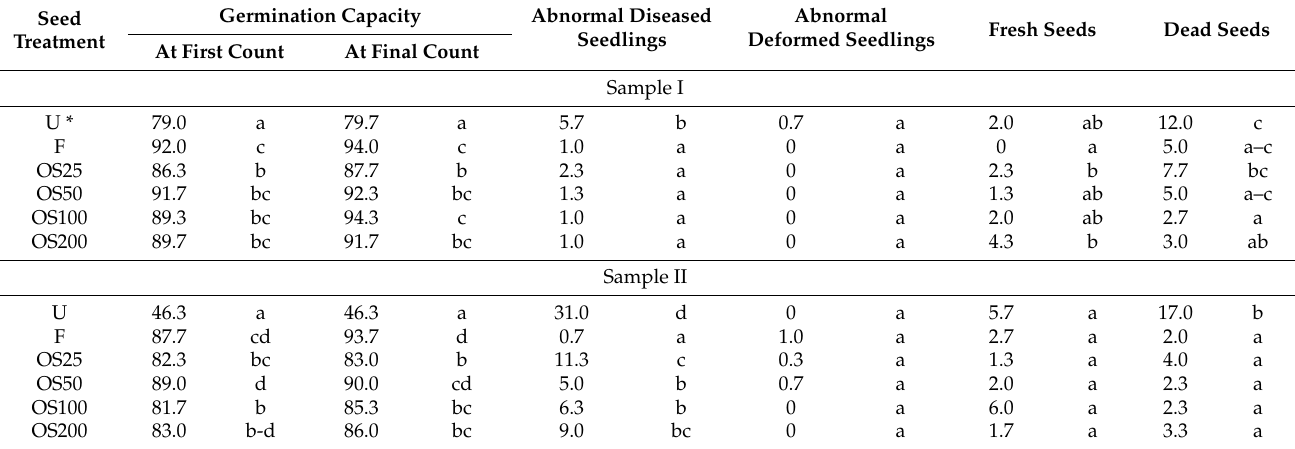
Table 1. Effects of osmopriming with the addition of melatonin on the seed germination of D. carota ‘Amsterdamska’ seeds (%).